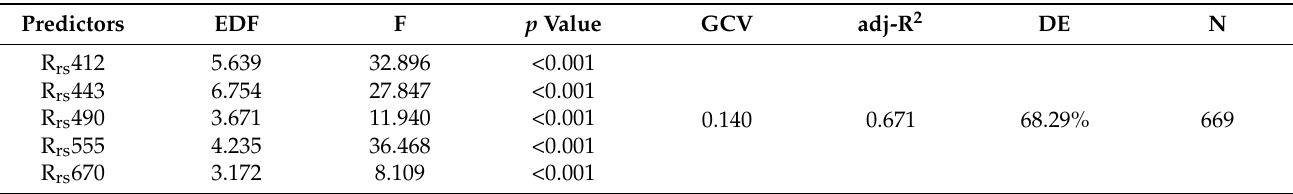
Table 5. Statistical summary of the fitted Pico GAM.